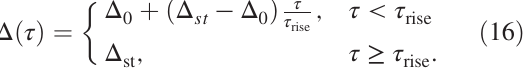
becomes complex and the eigenmodes are unstable.